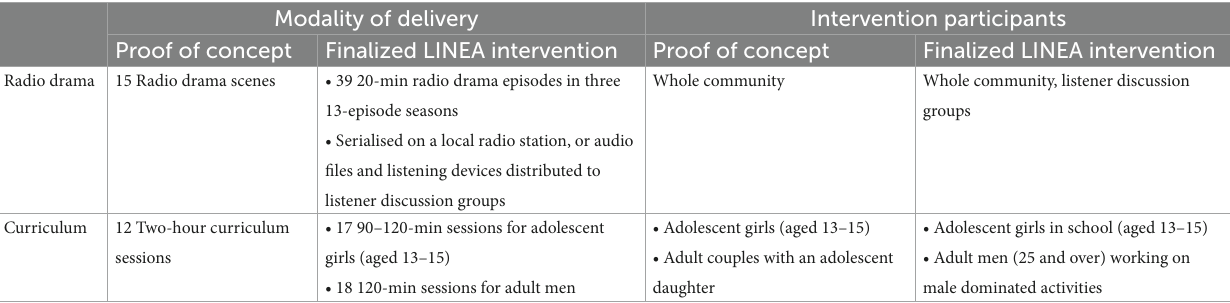
TABLE 4 Comparison between the learning initiative on norms, exploitation, and abuse (LINEA) intervention proof of concept, and the finalized LINEA intervention. Modality of